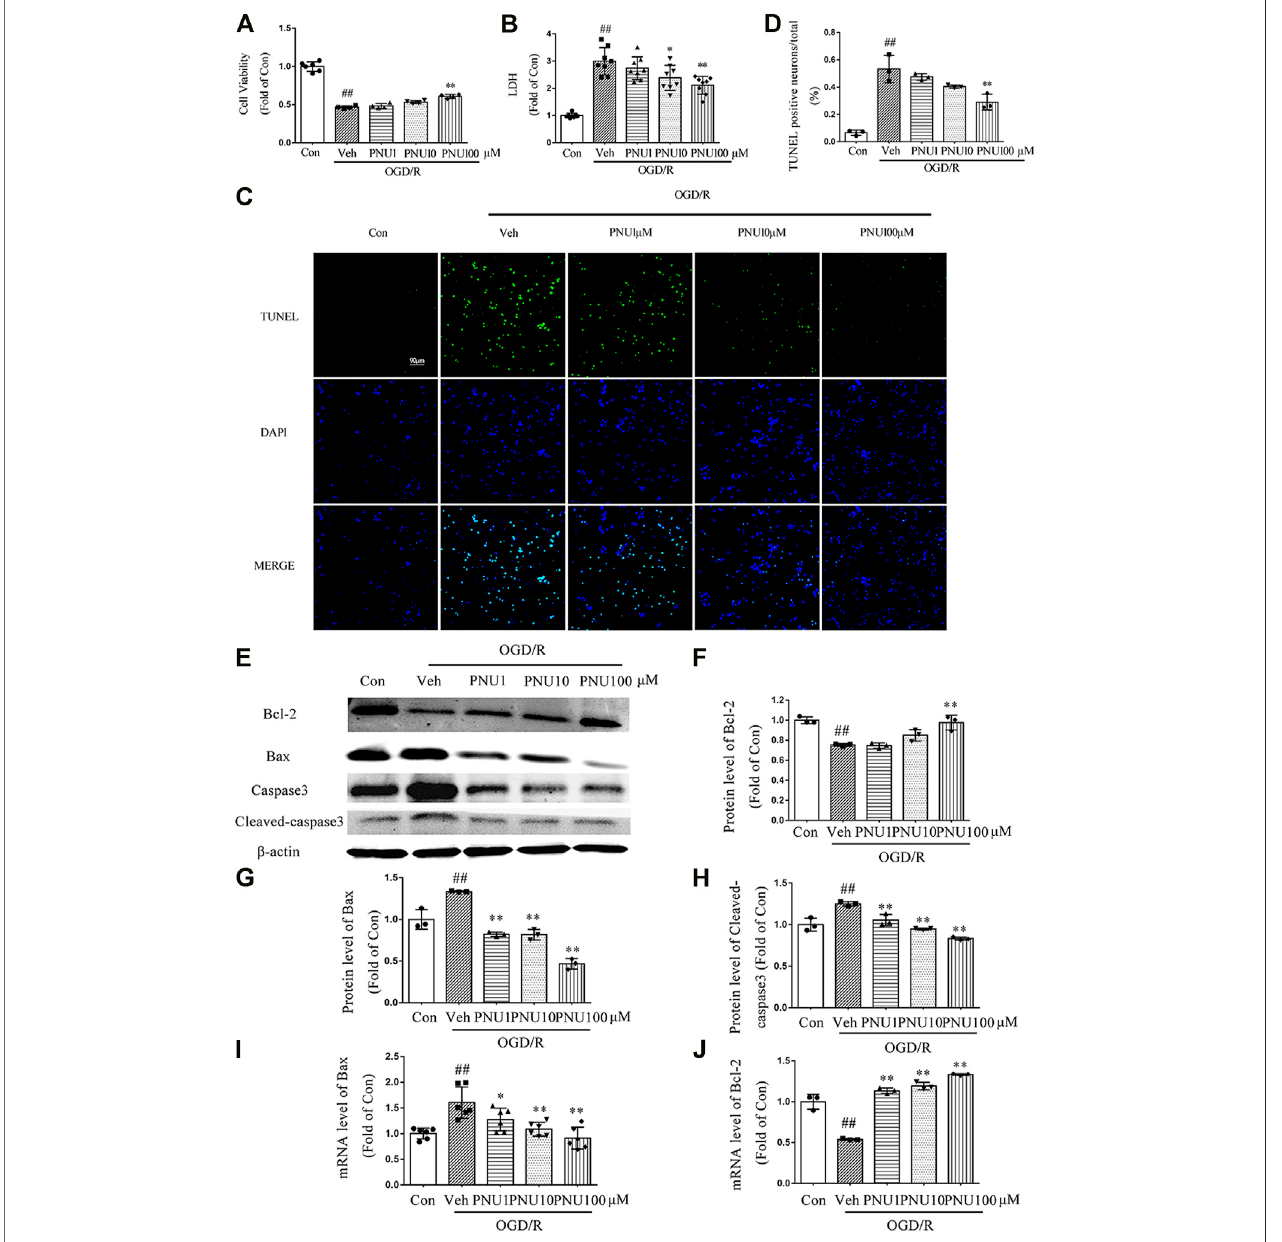
FIGURE2| PNU282987dose-dependentlyprotectsneuronsfromOGD/Rinjury.PrimarycorticalneuronswerepretreatedwithvehicleorPNU282987(1 ,10,and 100 μ M) for 2 h before OGD/R exposure. The cell viability and LDH release were examined at 24 h upon OGD/R exposure. (A) PNU282987 100 μ M could increase the cellviabilitycomparedtothatintheOGDVehgroup. n (cid:2) 4 – 6foreachgroup. (B) PNU282987100 μ McoulddecreasetheLDHreleasecomparedtothatintheOGDVeh group. n (cid:2) 8 for each group. (C) Representative images of TUNEL. PNU282987 (10 and 100 μ M) dose-dependently reduced the number of apoptotic neurons by TUNEL staining. Scale bar, 90 μ m. (D) Quanti fi cation of apoptotic neurons. n (cid:2) 3 for each group (E – H) Apoptosis-related proteins including Bcl-2, Bax, caspase 3, and cleavedcaspase3weredetectedbyWesternblot. n (cid:2) 3foreachgroup. (I,J) Apoptosis-relatedmRNAincludingBcl-2andBaxweredetectedbyreal-timePCR. n (cid:2) 3 – 6 for each group. ## p < 0.01 vs. con; * p < 0.05 vs . OGD/R veh; and ** p < 0.01 vs. OGD/R